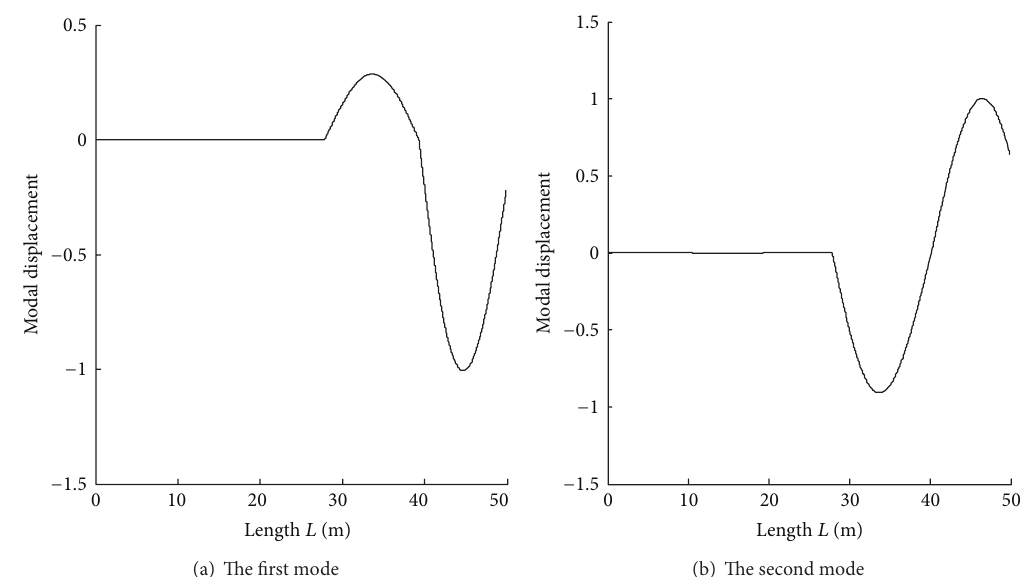
Figure 4: Modal of vibration of the boom system: (a) the first mode, (b) the second mode.